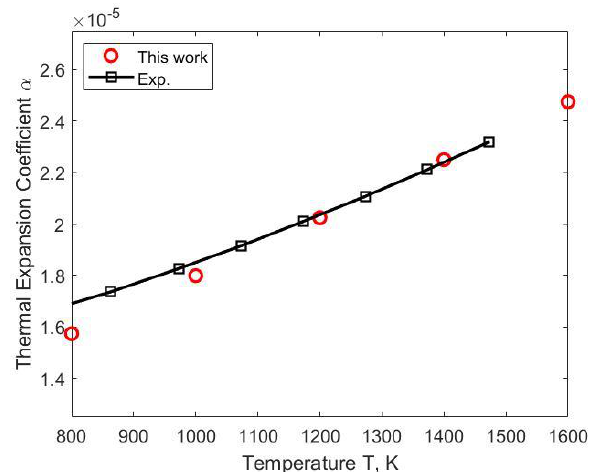
Figure 5. Thermal expansion coefficient of nickel as a function of temperature. Experimental data are from [46].